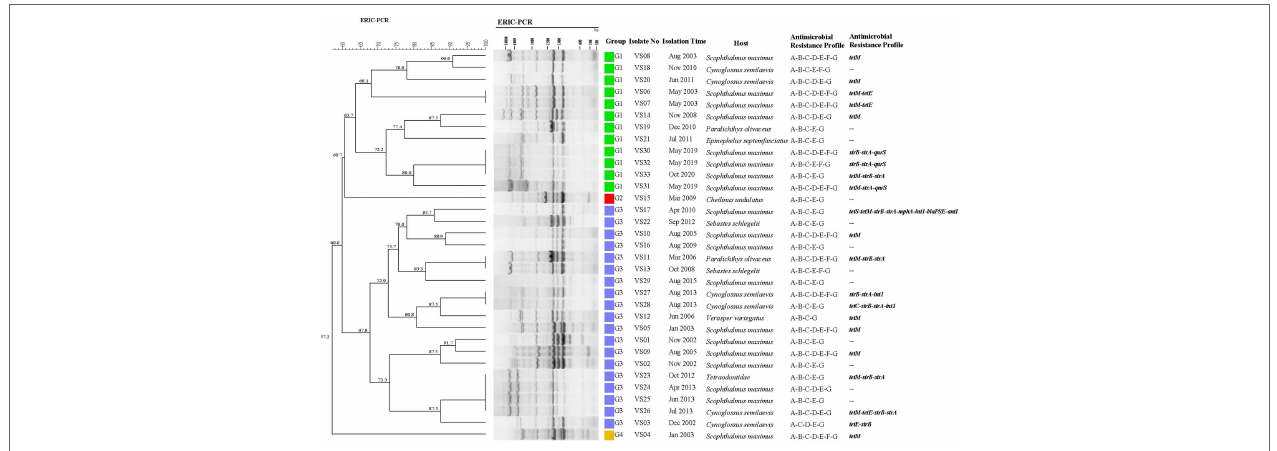
FIGURE 4 | Phylogenetic analysis of 33 V. scophthalmi isolates based on